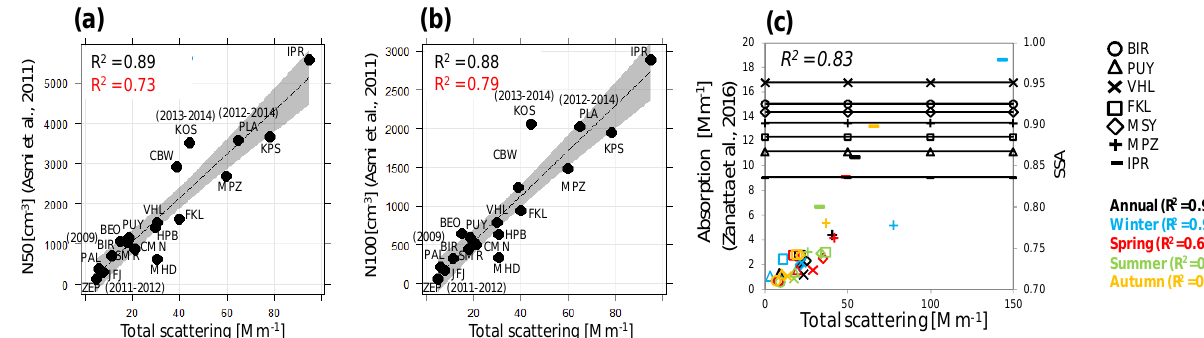
Figure 3. Relationship between (a) N 50 (mean particle number concentration between 50 and 500nm), (b) N 100 (mean particle number concentration between 100 and 500nm), (c) absorption coefficient and mean aerosol particle total scattering coefficient. (a, b) Data averaged over the period 2008–2009. For ZEP, BIR, KOS and PLA aerosol particle-scattering measurements were not available during 2008–2009 and different periods were used. R 2 values, highlighted in red, were obtained using the median values. (c) Data averaged as in Zanatta et al. (2016). Panel (c) also reports the geometric mean of